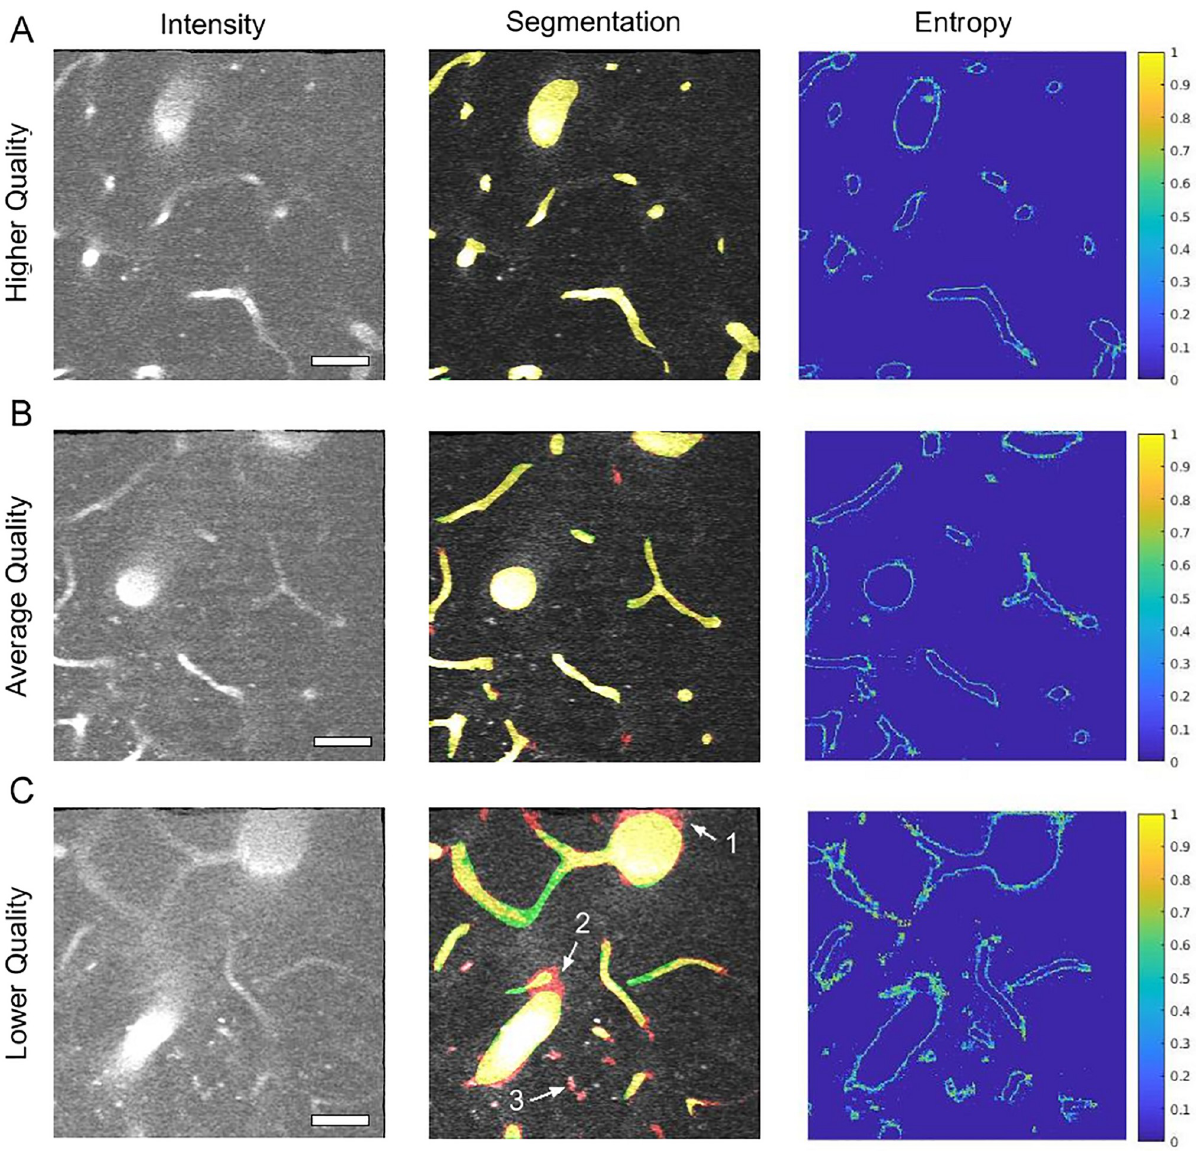
Fig 6. Comparison of DeepVess and the gold standard human expert segmentation results in image planes as shown in Fig 5. Imaging is generally higher quality at planes closer to the sample surface. (Left column) Image intensity shown with gray scale after motion artifact removal. The dark spots within the vessels are red blood cells that do not take up the injected dye. (Middle column) Comparison between DeepVess (red) and the expert (green) segmentation results overlaid on images. Yellow shows agreement between the two segmentations. (Right column) Shannon entropy, which is a metric of DeepVess segmentation uncertainty computed with 50% dropout at test-time [44]. The boundaries of vessels with high entropy values, shown in warmer colors, demonstrate the uncertainty of DeepVess results at those locations. Scale bar is 50 μm .